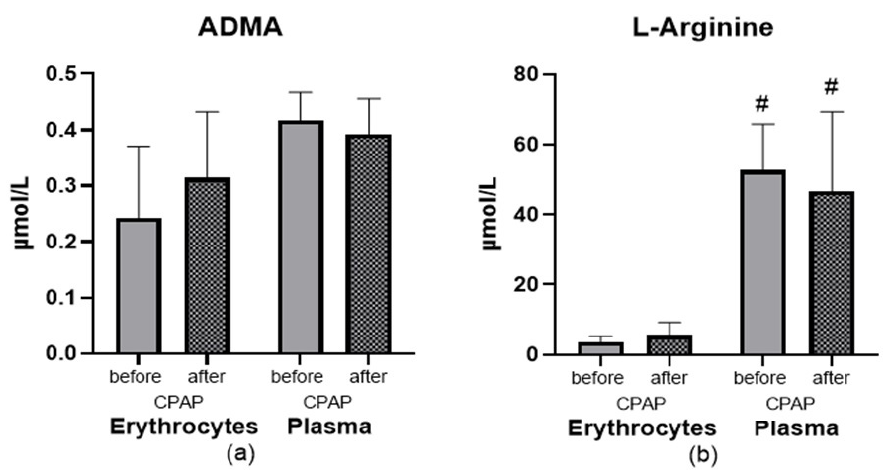
Figure 6. ( a , b ). The effect of 1-year CPAP therapy on the bioavailability of NO metabolites. Bars and whiskers represent the mean ± SD. Abbreviations: ADMA: asymmetric dimethylarginine; OSA: obstructive sleep apnea. # denotes p < 0.05 between compartments in the same group.